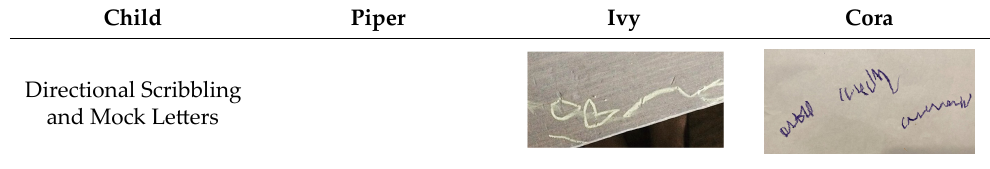
Table 1. The Pre-Alphabetic Stage.